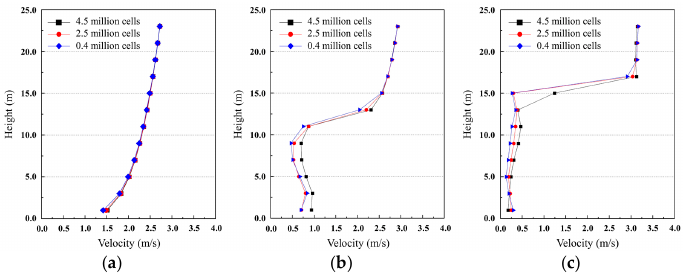
Figure 5. Velocity profile results for grid independence test: ( a ) Line 1; ( b ) Line 2; ( c ) Line 3.